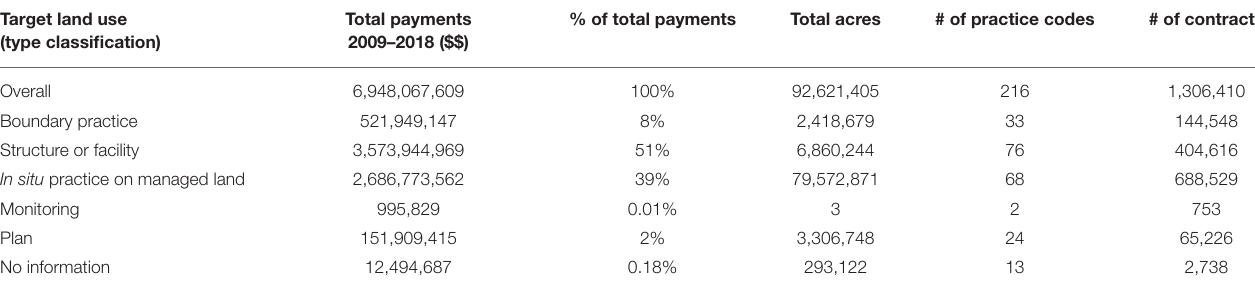
TABLE 1 | Dollars allocated to practices that fell within different categories in the classification of type of practice, describing its targeted land use. Target land use (type classification)